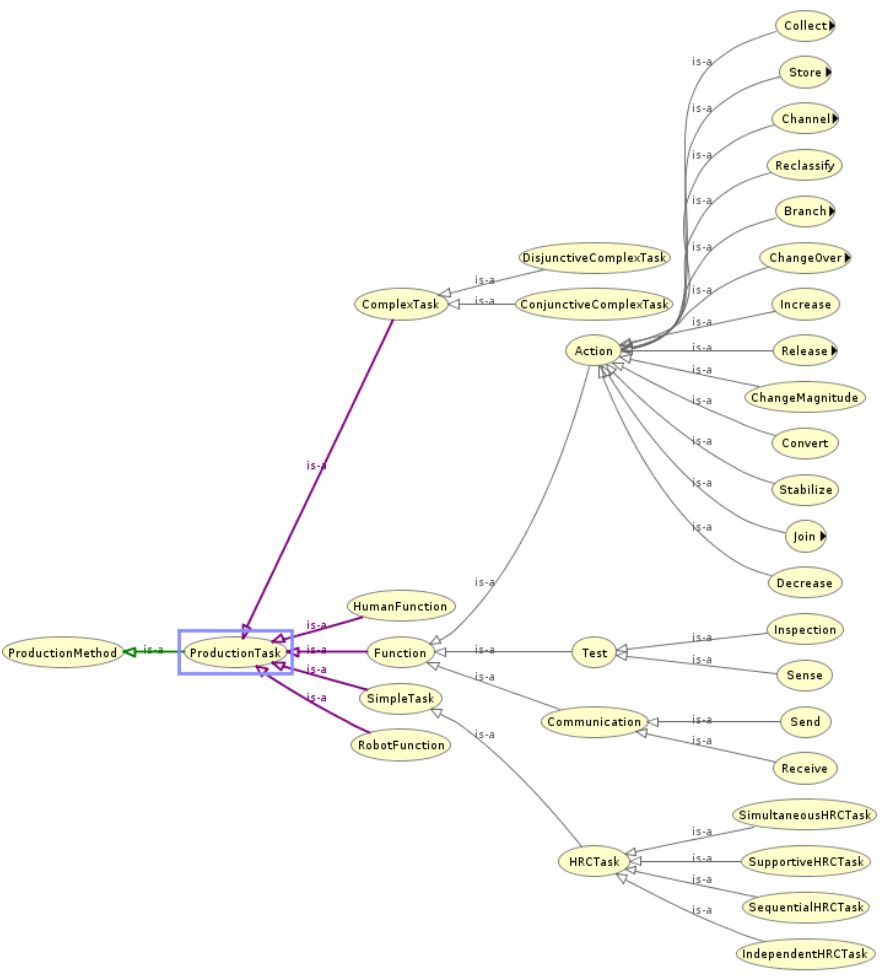
Figure 3. Excerpt of SOHO showing the taxonomical structure of production tasks. In particular the picture shows the integrated taxonomy of functions introduced in